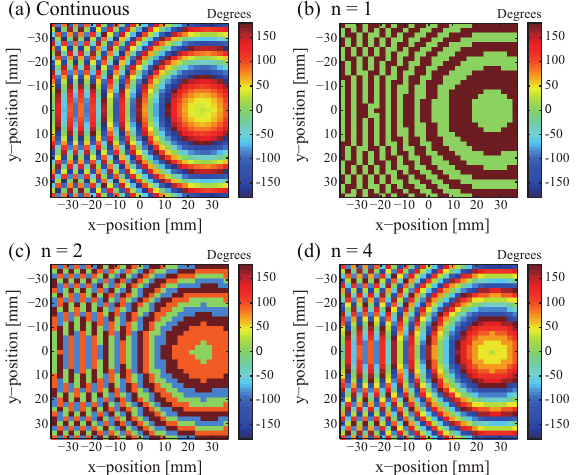
Figure 5. Required phase patterns for 20 ◦ -steered digitized metal reflectarray antennas for a non- digitized case and three different bits, n = 1, 2, and